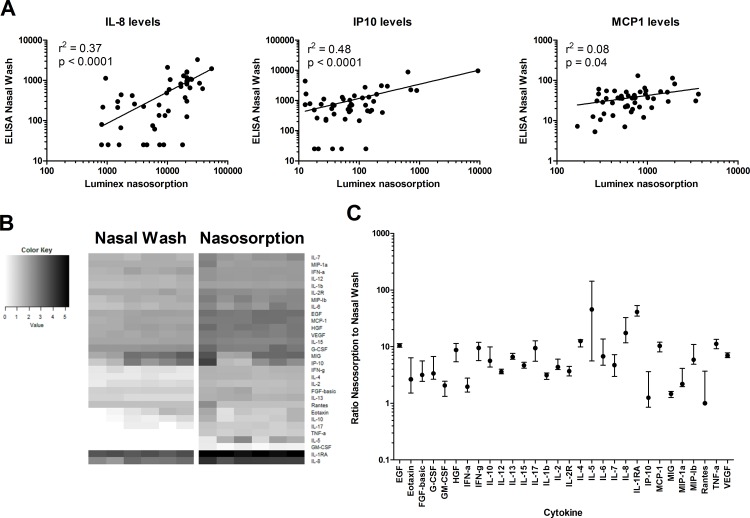
Comparison of cytokine levels in samples collected by nasal wash and using nasosorption devices.(A) Levels of IL-8, IP-10 and MCP1 were measured by Luminex in nasosorption devices and by ELISA from paired nasal washes (n = 41). The r2 and p indicate goodness-of-fit and p-value calculated by linear regression analysis (B) A heat map depicts log-transformed cytokine concentrations, with white and black indicating low and high levels, respectively. Each of the columns corresponds to one sample (n = 6 nasal wash and nasosorption) and each of the rows to one cytokine. A legend assigning color gradient to log-transformed cytokine levels is displayed. (C) The ratio of cytokine concentrations measured in paired nasosorption and nasal wash (median and IQR are shown, n = 6).